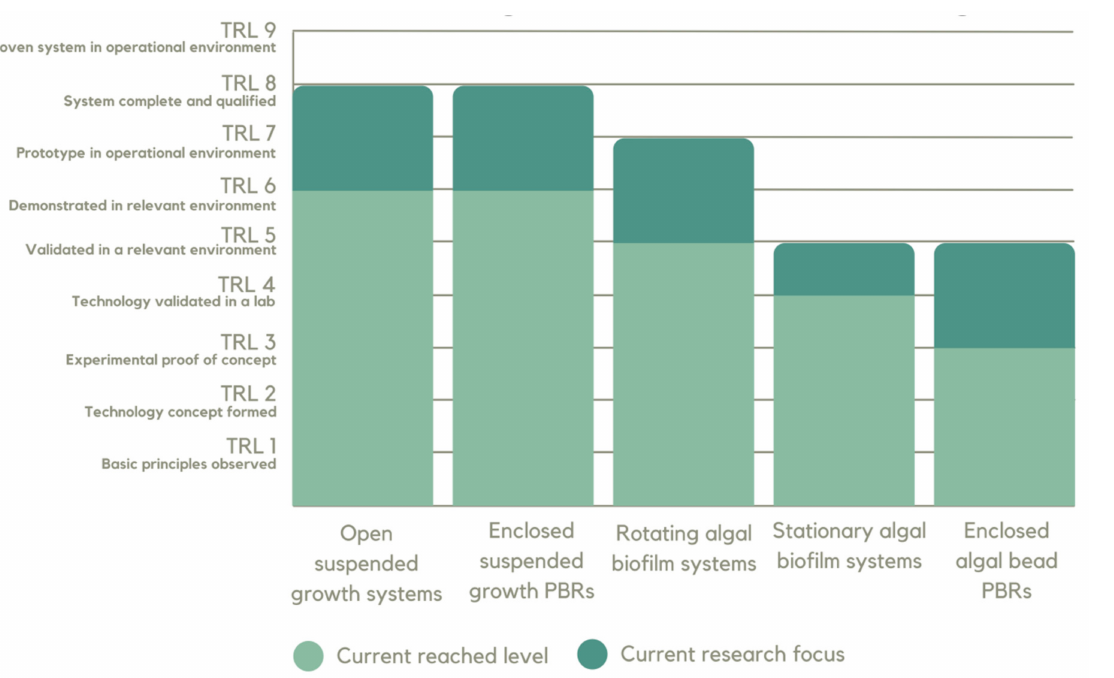
Figure 13. Technology readiness level of the main algae-based wastewater treatment technologies for secondary treated